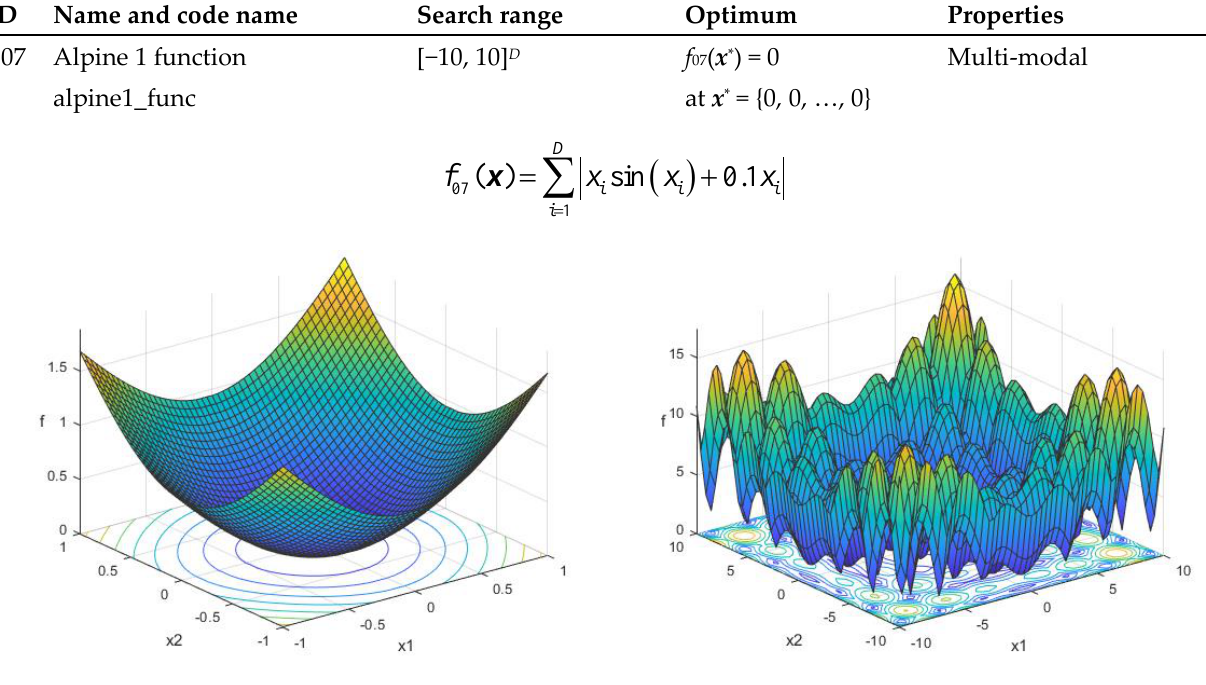
Figure A7. Alpine 1 function in two dimensions.